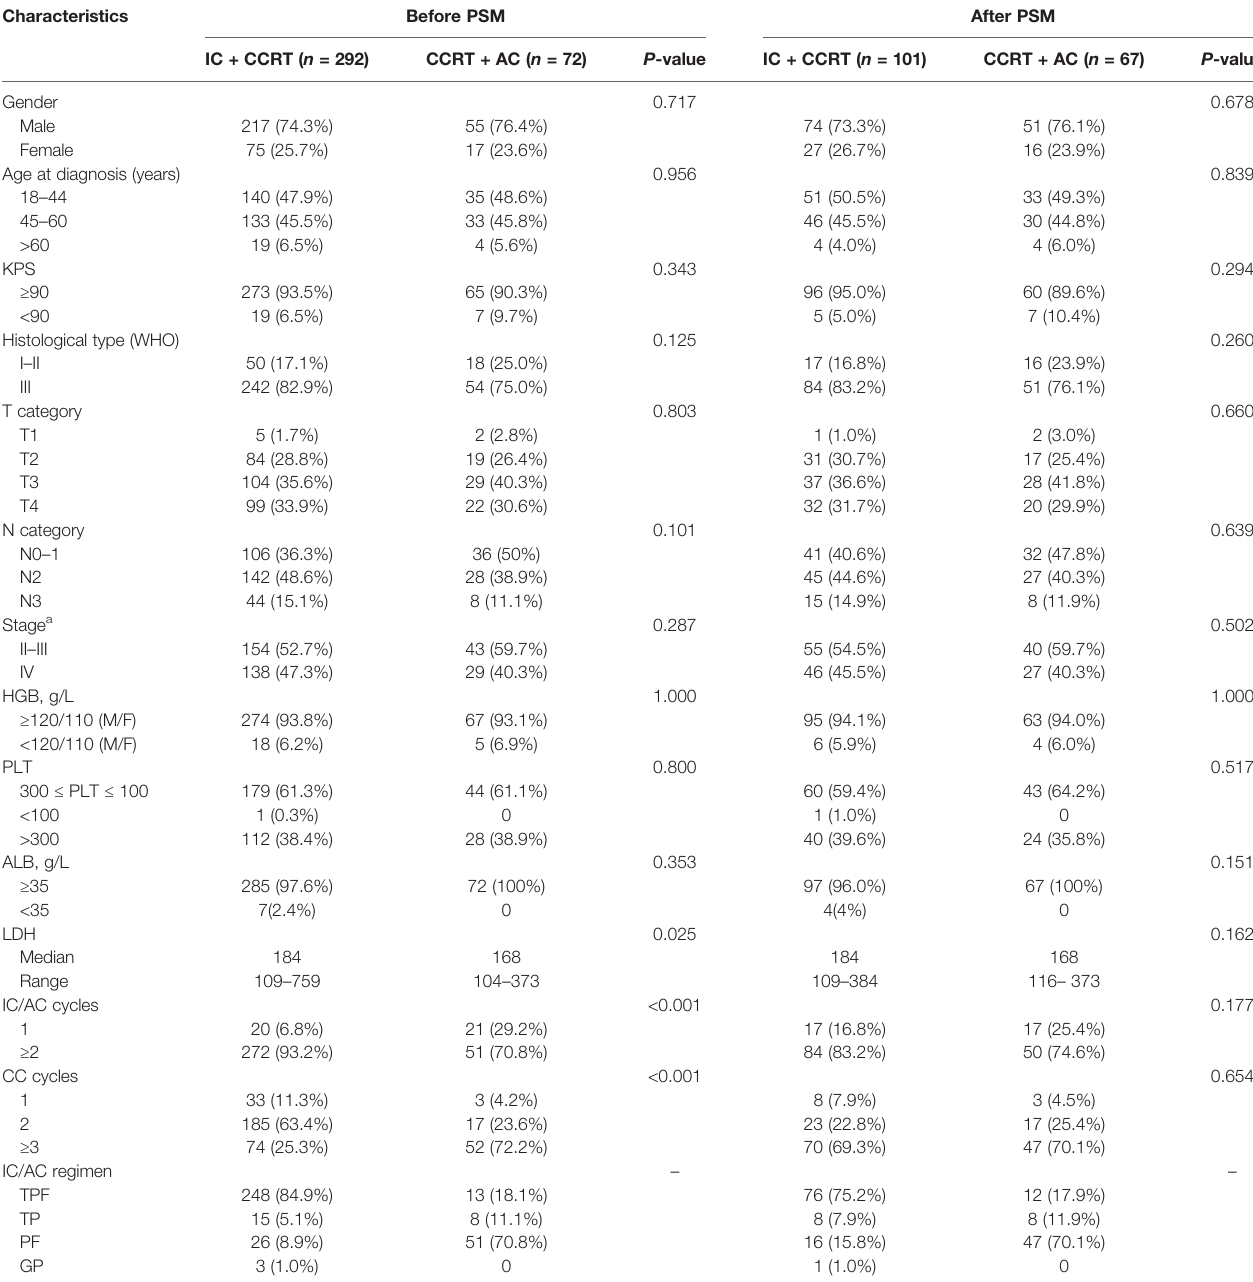
TABLE 1 | Baseline patient characteristics before and after PSM.